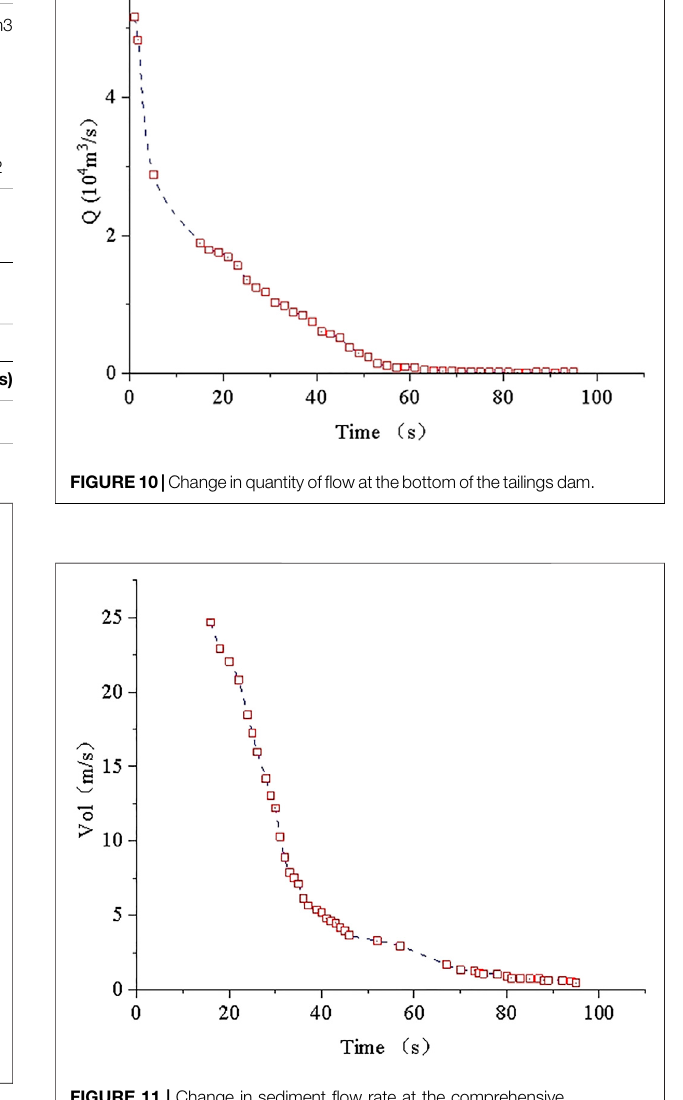
FIGURE 11 | Change in sediment fl ow rate at the comprehensive